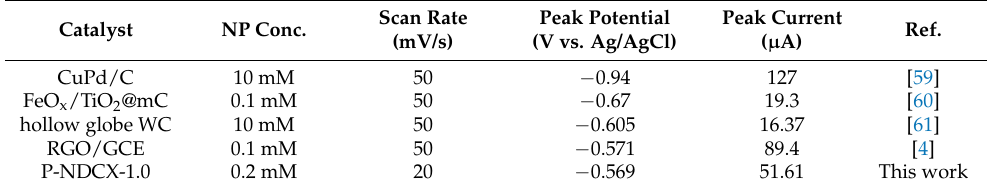
Table 4. Comparison of the activity of P-NDCX-1.0 for the electro-reduction of p-NP with other materials reported in the